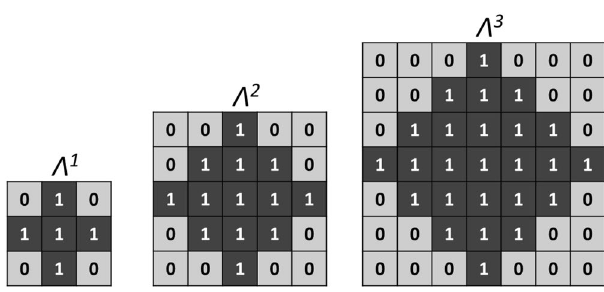
1 2 3 , (cid:31) , (cid:31)